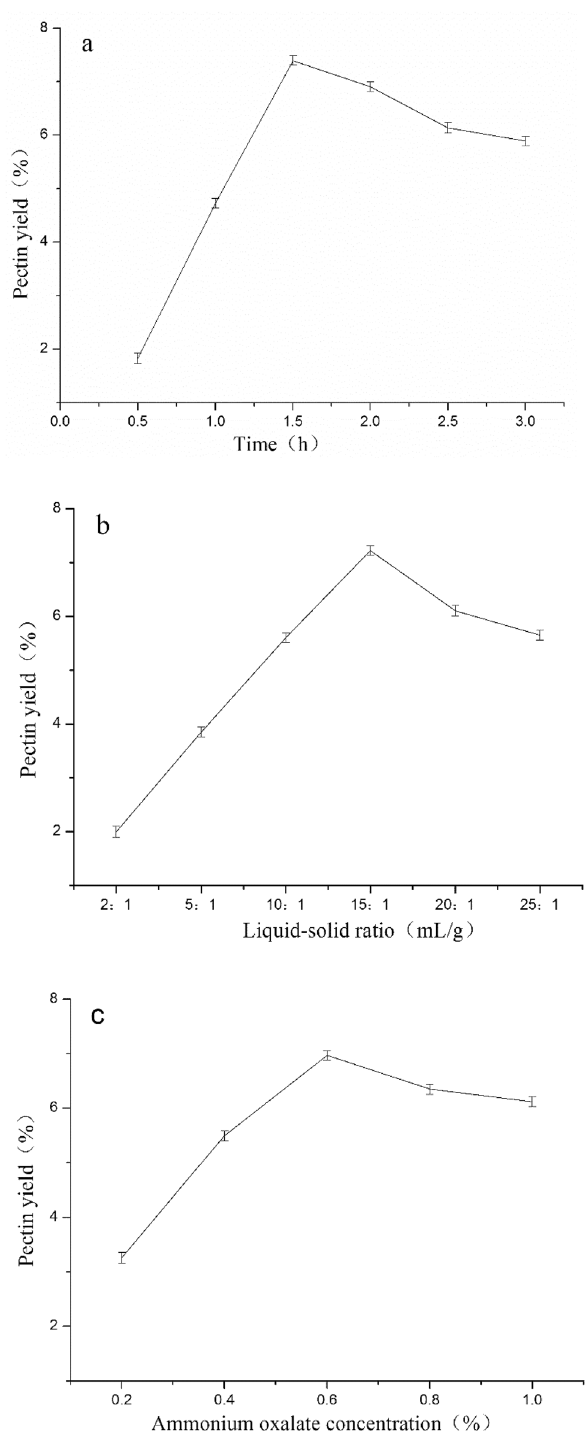
Figure 1. Single factor analysis showing the effect of each independent variable ( a time, b liquid–solid, c ammonium oxalate) on the yield of the